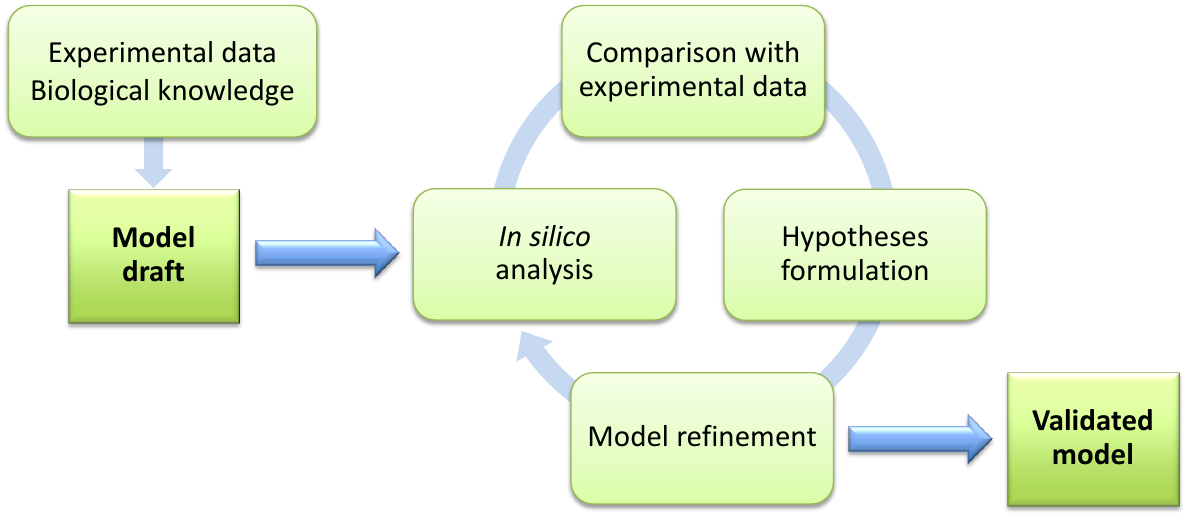
Figure 4. Schematic representation of the validation process of mathematical models.